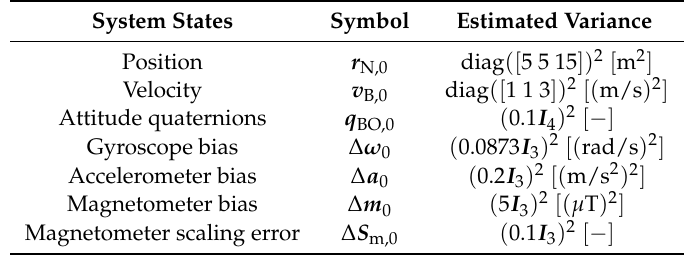
Table 3. Diagonal elements of the estimated initial states error covariance matrix ¯ P 0 .